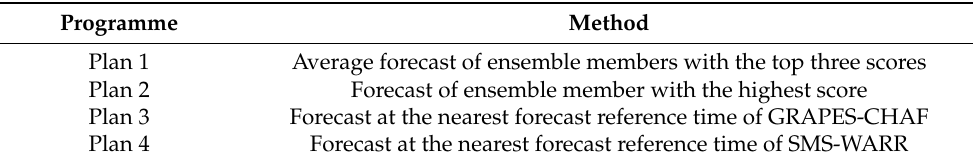
Table 4. Four calculation plans of forecast products.